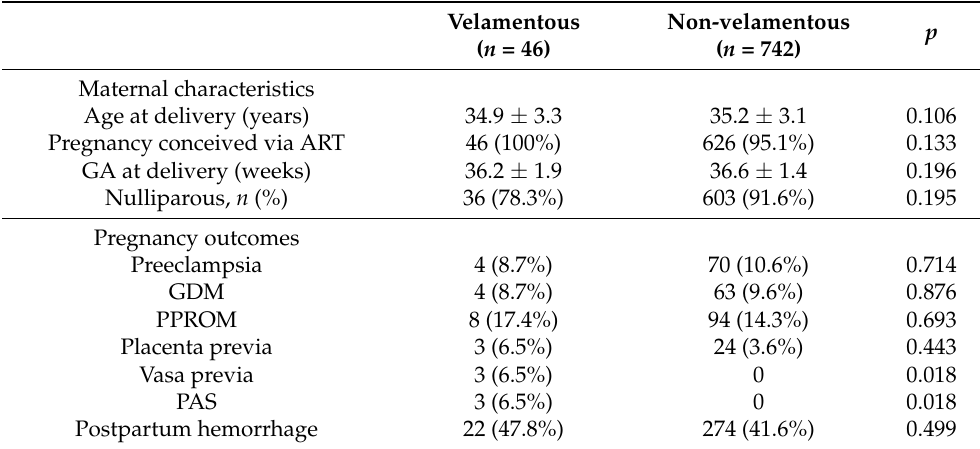
Table 3. Comparison of maternal characteristics and perinatal outcomes in dichorionic twin pregnan- cies according to velamentous cord insertion ( n =